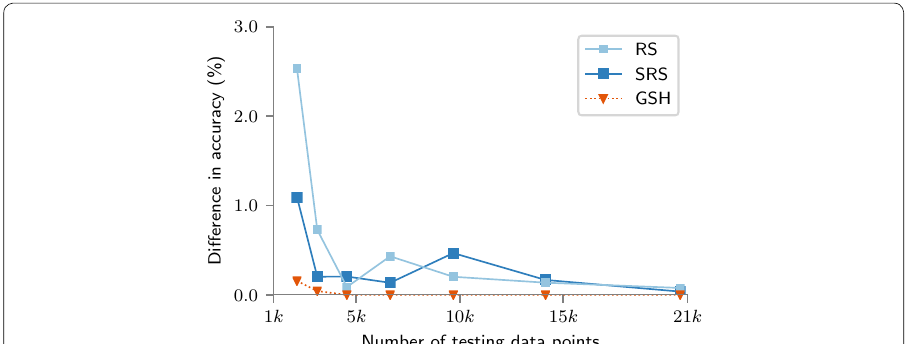
Fig. 14 Difference in prediction accuracies from LIBSVM for the approaches